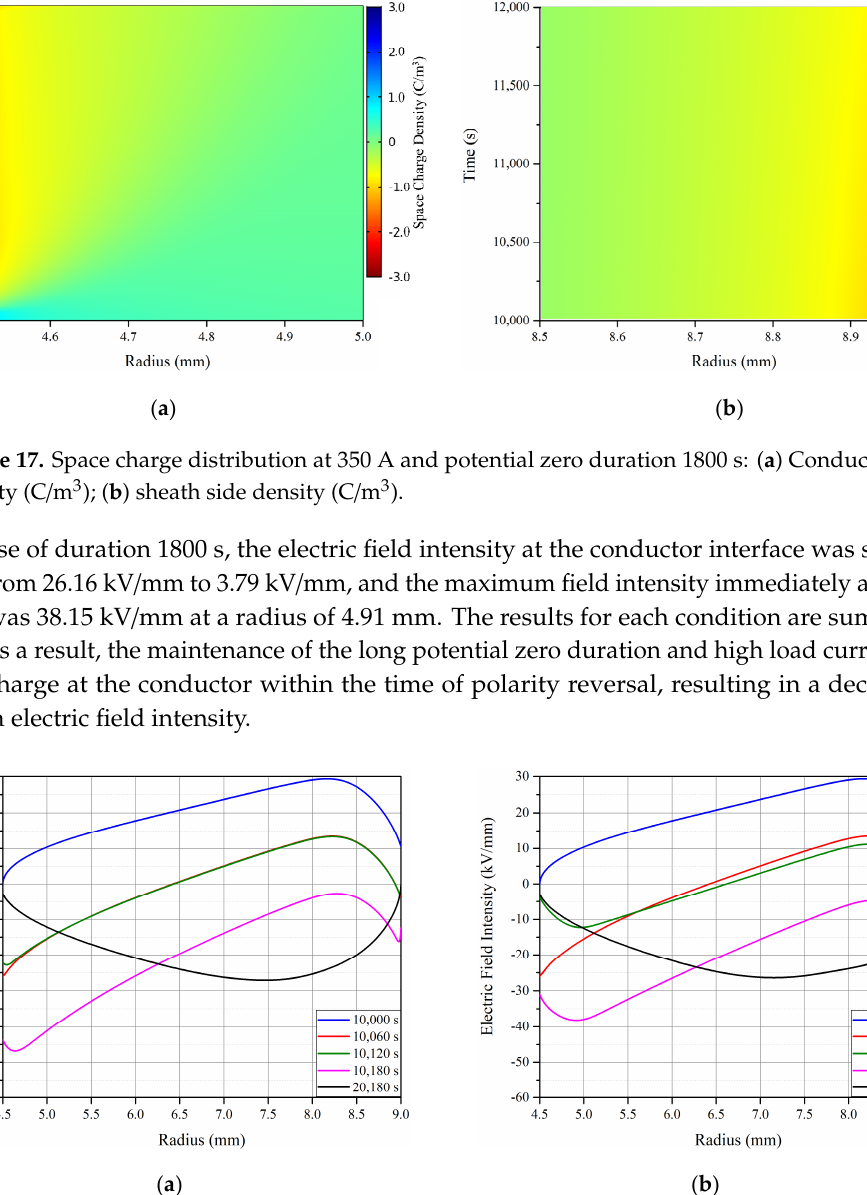
Figure 17. Space charge distribution at 350 A and potential zero duration 1800 s: ( a ) Conductor side density (C/m 3 ); ( b ) sheath side density (C/m 3 ).